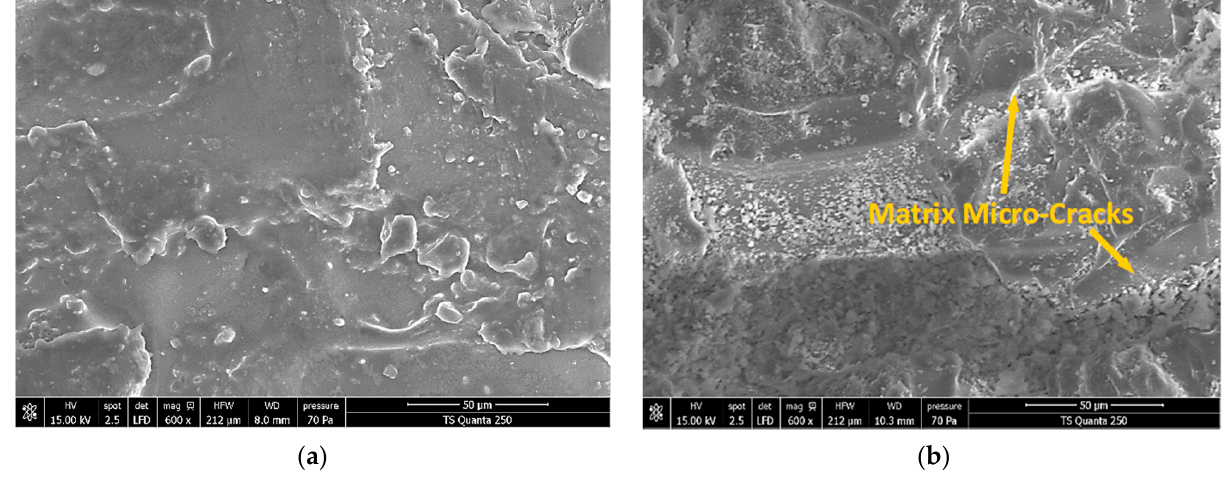
Figure 8. SEM Micrographs obtained before and after edge trimming pure epoxy matrices (sample A). ( a ) Pure epoxy (before machining). ( b ) Machined pure epoxy-f = 50 mm ∙ min − 1 .